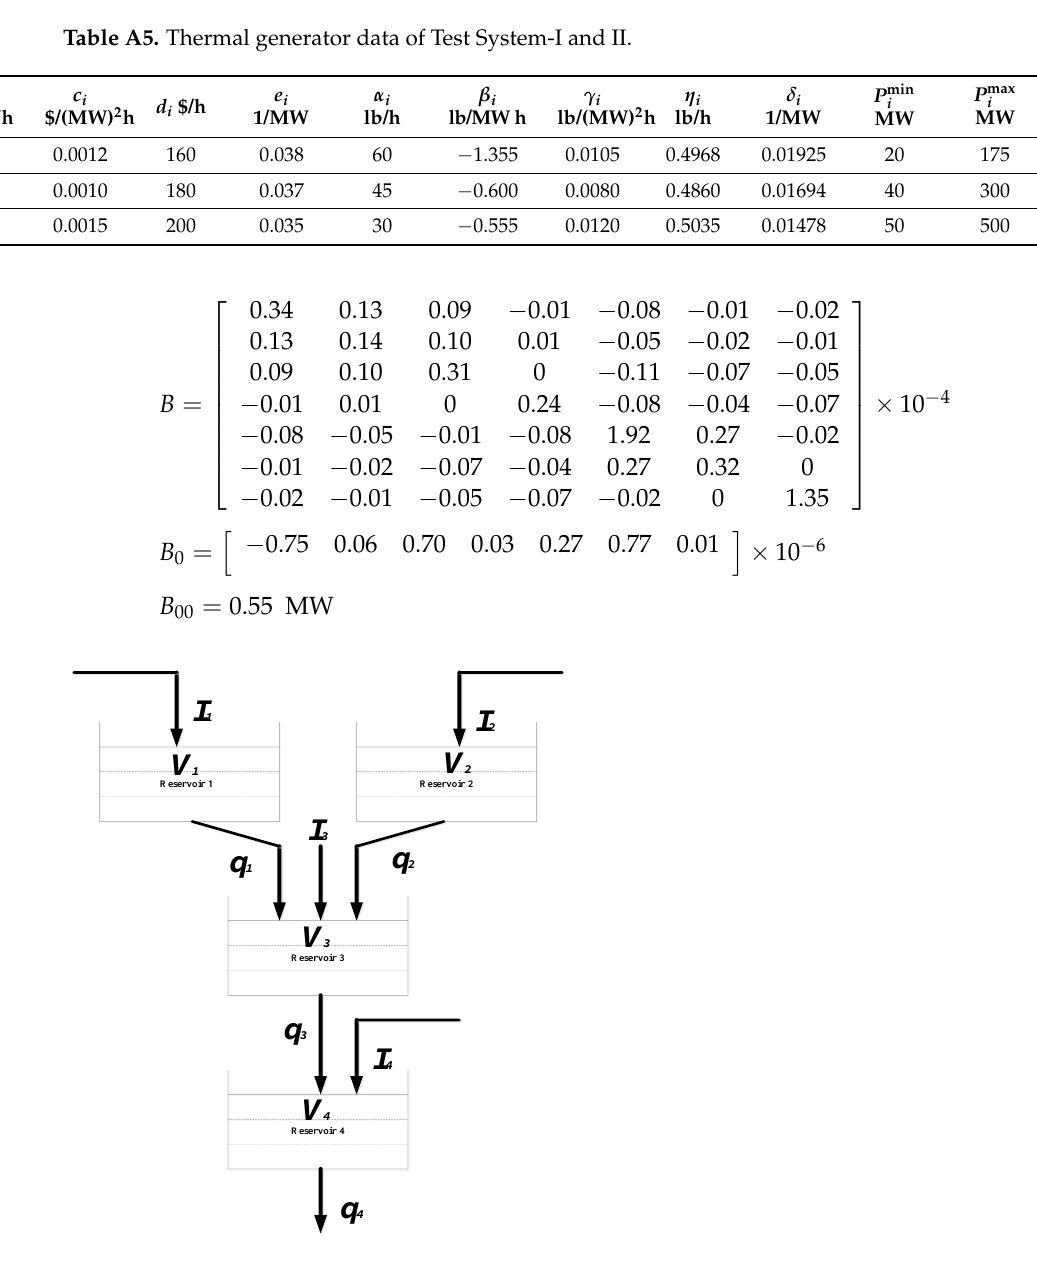
Figure A1. Hydraulic network configuration for cascaded MSHTS of Test system-I and II.